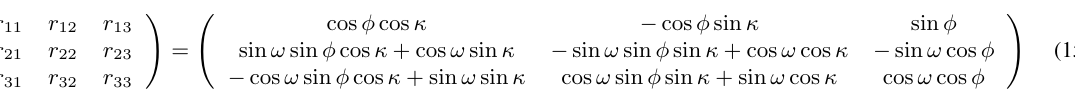
Table 2: Rotation matrix with ω rotation on x -axis, φ rotation on y -axis and κ rotation on z -axis, from local camera system to object system.